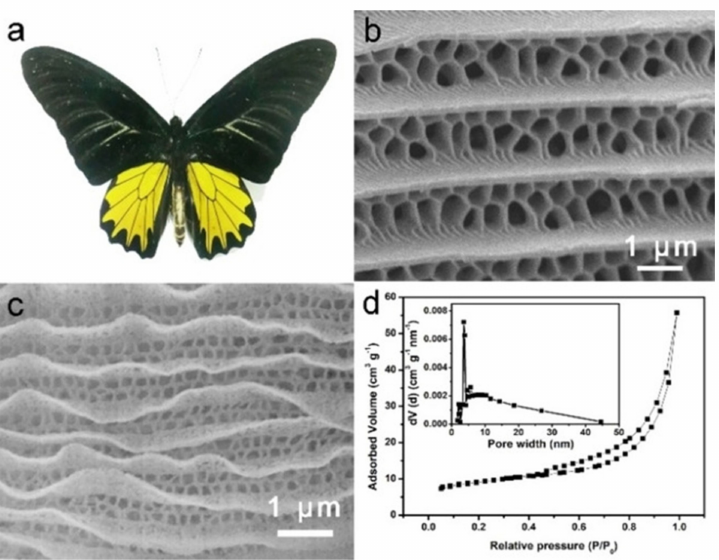
Figure 2. Figure extracted from Tong et al. (2021) [26]. Picture ( a ) shows an image of the Troides Helena butterfly used as a template. Pictures ( b , c ) compare the original template and the templated material, respectively. Although the structure was accurately replicated, pores diminished their sizes and ridges changed their straight disposition. Picture ( d ) shows nitrogen adsorption/desorption isotherm and pore size distribution of the biotemplated electrode. Reproduced with the permission of